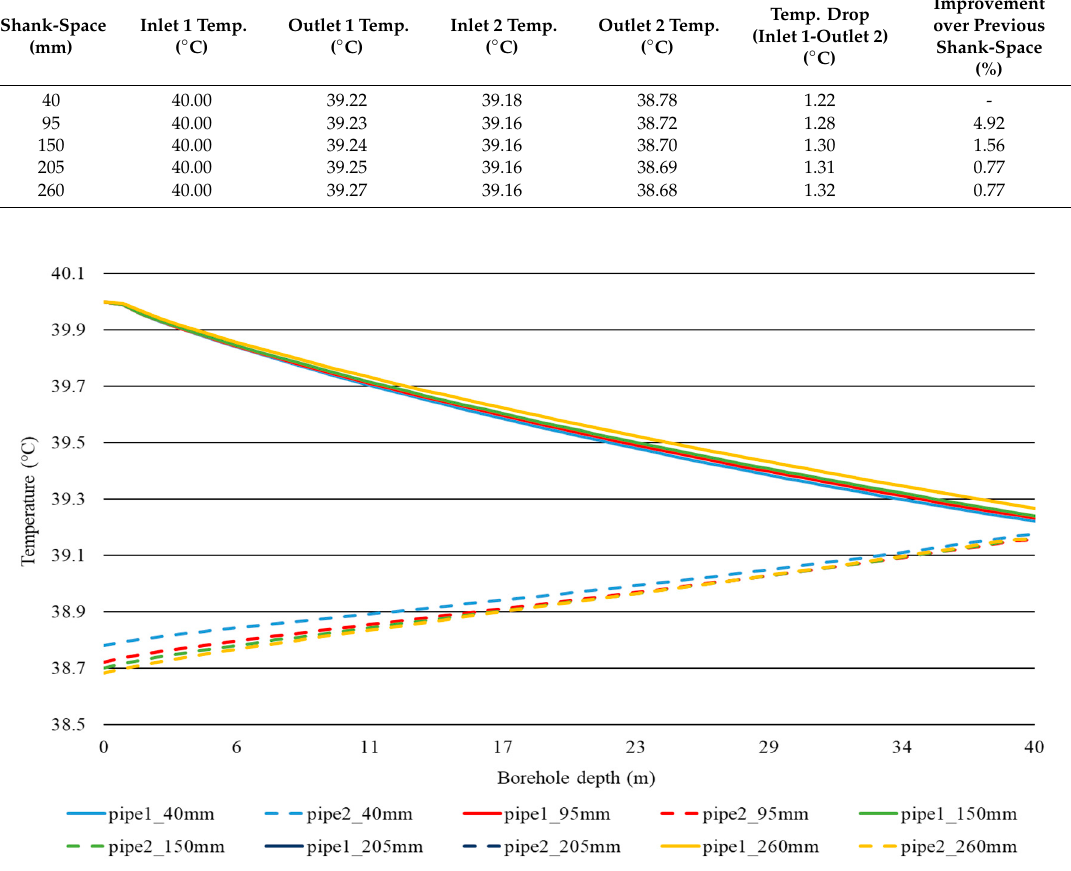
Figure 7. Variation of fluid temperature with depth for the five shank-spaces investigated for the 40 m borehole.